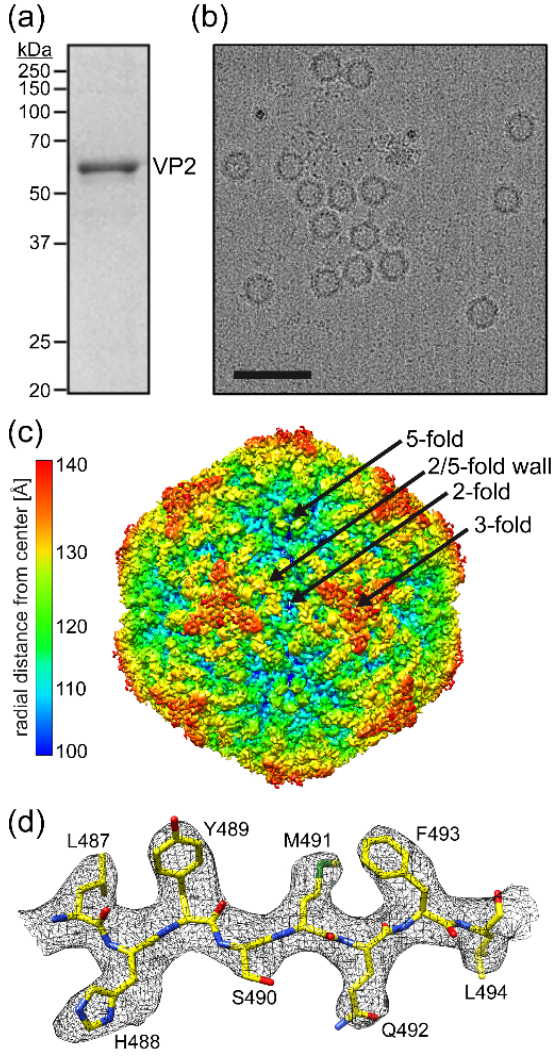
Figure 1. Determination of the PARV4 capsid structure. ( a ) SDS-PAGE of purified PARV4 VLPs, with a band at ~60 kDa equivalent to the size of VP2. ( b ) Example cryo-electron micrograph of PARV4. Scale bar: 500 Å. ( c ) The capsid surface density map contoured at a sigma ( σ ) threshold level of 1.0. The map is radially colored (blue to red) according to distance to the capsid center, as indicated by the scale bar on the left. The approximate icosahedral two-, three-, and five-fold axes are indicated. ( d ) Amino acid residues modeled for the β I strand are shown inside their density maps (in black). The amino acid residues are as labeled and shown as stick representations and colored according to atom type: C = yellow, O = red, N = blue, S = green. Panels ( c , d ) were generated using UCSF-Chimera [25]. As the capsids appeared uniform, the AMDV sample was deemed suitable for high- resolution structural determination. Three-dimensional-image reconstruction of a total of 93,393 individual AMDV capsids resulted in a resolution of 2.37 Å, based on an FSC threshold of 0.143 (Table 1). The reconstructed capsid of AMDV, the first determined structure of the genus Amdoparvovirus , also displayed familiar surface features, as described above, with channels at the icosahedral five-fold axes, protrusions near the three-fold axes, and depressions at the two-fold axes and surrounding the five-fold axes (Figure 2d) [3]. Previously, the capsid structure of AMDV was determined by cryo-EM at ~22 Å resolution and showed the same overall capsid surface features